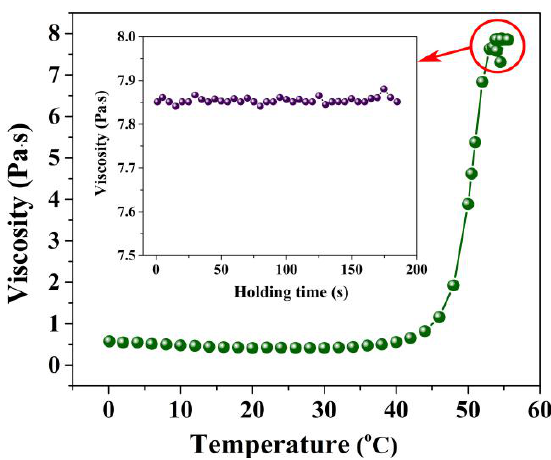
Fig. 4 Viscosity property of alumina slurry with 0.4 wt% carrageenan on heating (solid loading was 50 vol%).